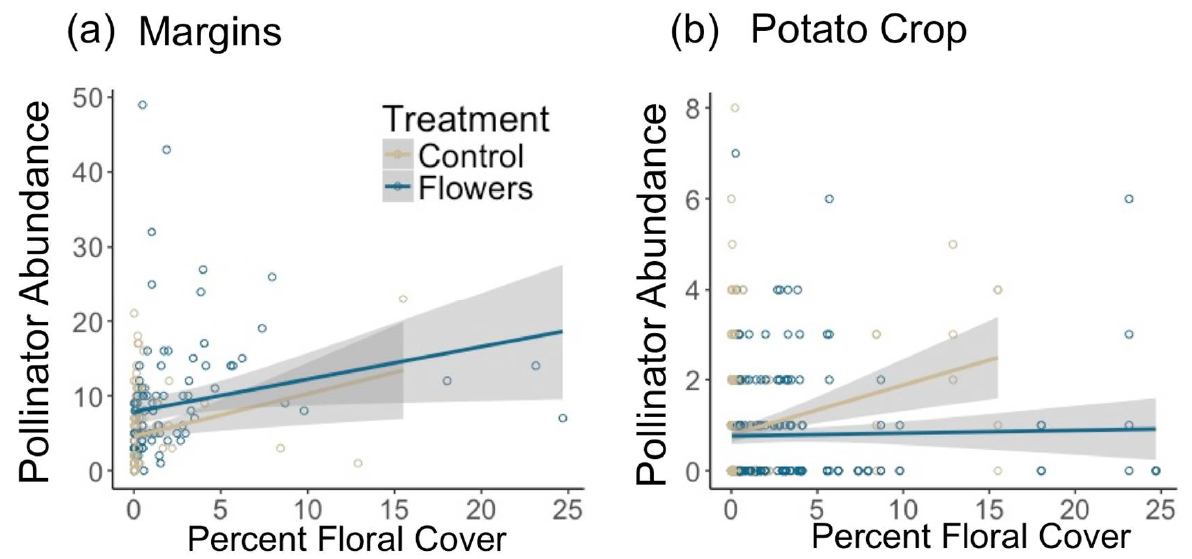
Figure 3. Effect of floral cover on pollinator abundance in ( a ) field margins and ( b ) potato crops. Shaded area represents 95% confidence interval.